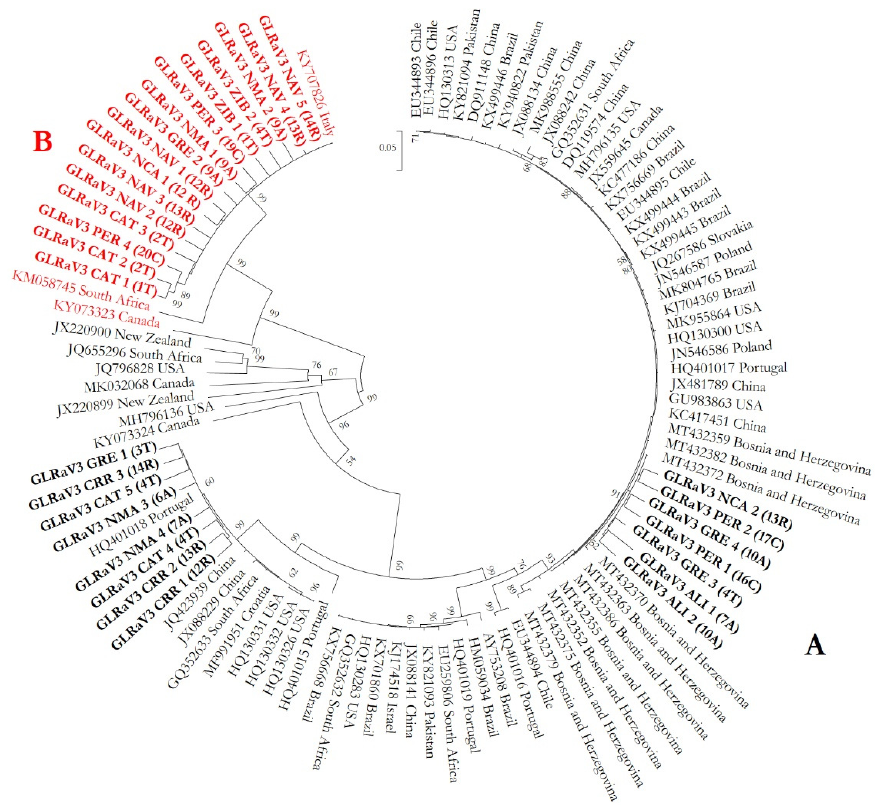
Figure 2. Phylogenetic relatedness between 31 Sicilian GLRaV ‐ 3 isolates and reference isolates retrieved from NCBI, based on coat protein gene. The evolutionary history was inferred by the maximum ‐ likelihood method (ML) using the Kimura 2 ‐ parameter model (K2) (1,000 replication bootstraps), conducted with the MEGA X program. Bootstrap values ≥ 50% are shown in the nodes. The sequences obtained in the present work are in bold. In brackets, the vineyard ID of origin (reported in Table 5). Black: cluster ( A ); red: cluster ( B ).